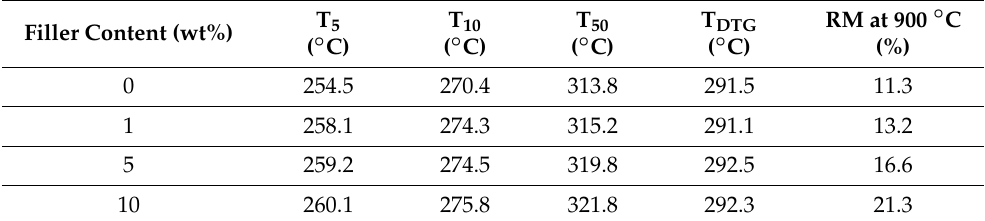
Figure 6. TG and DTG thermograms of PVC/hybrid filler composites tested in a nitrogen atmosphere. Table 1. The TG analysis